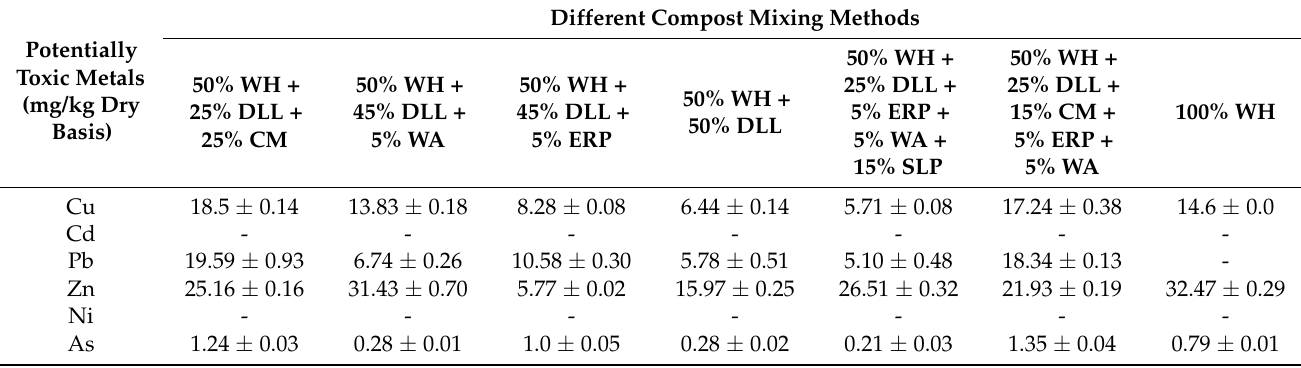
Table 3. Variation of potentially toxic metal concentration with different raw material mixing ratios